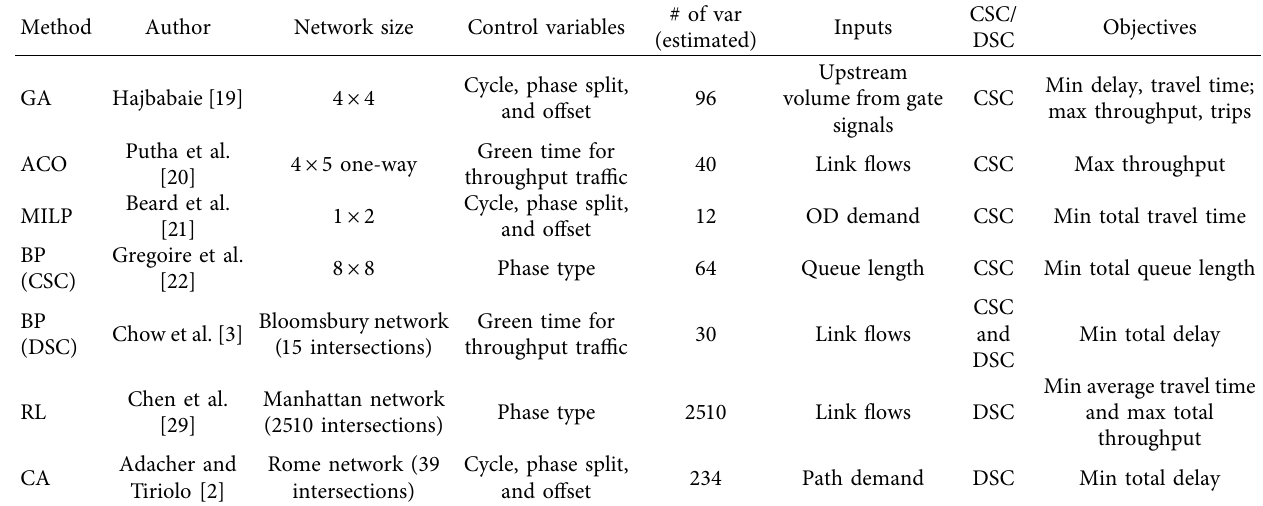
Table 1: List of methods for network signal